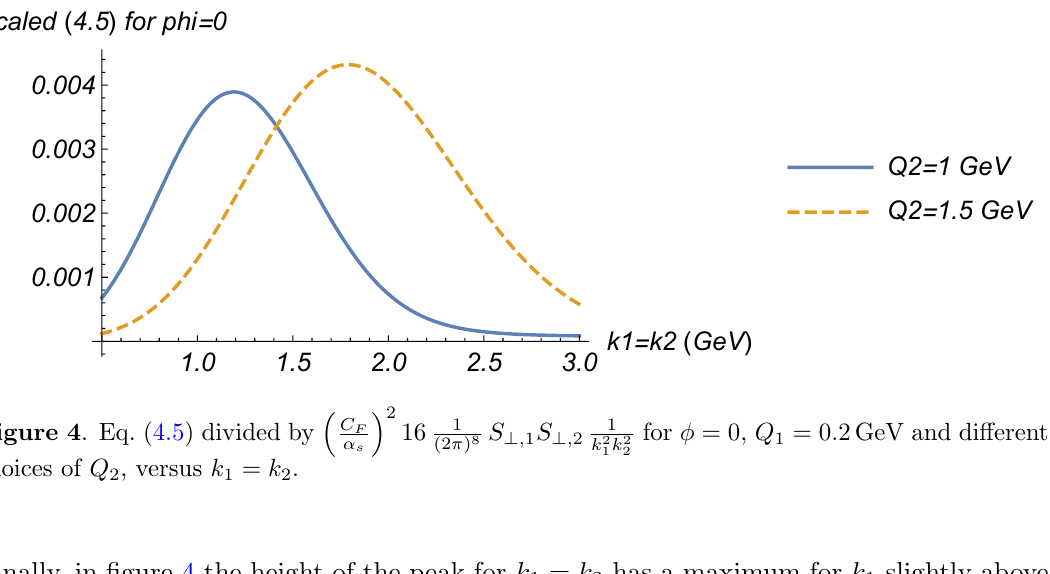
Figure 4 . Eq. (4.5) divided by choices of Q 2 , versus k 1 = k 2